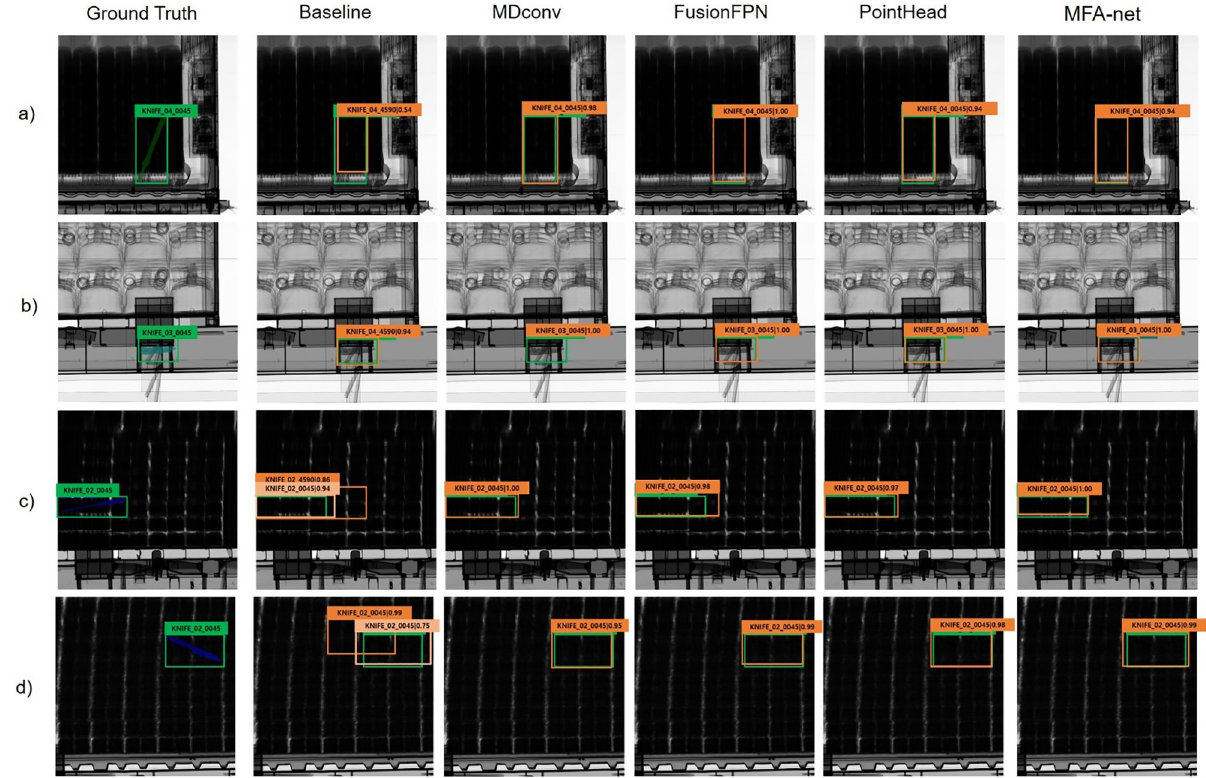
Fig 7. Visualization of the effect of the proposed MDConv, FusionFPN, point head, and MFA-net with all the proposed modules on CargoX.